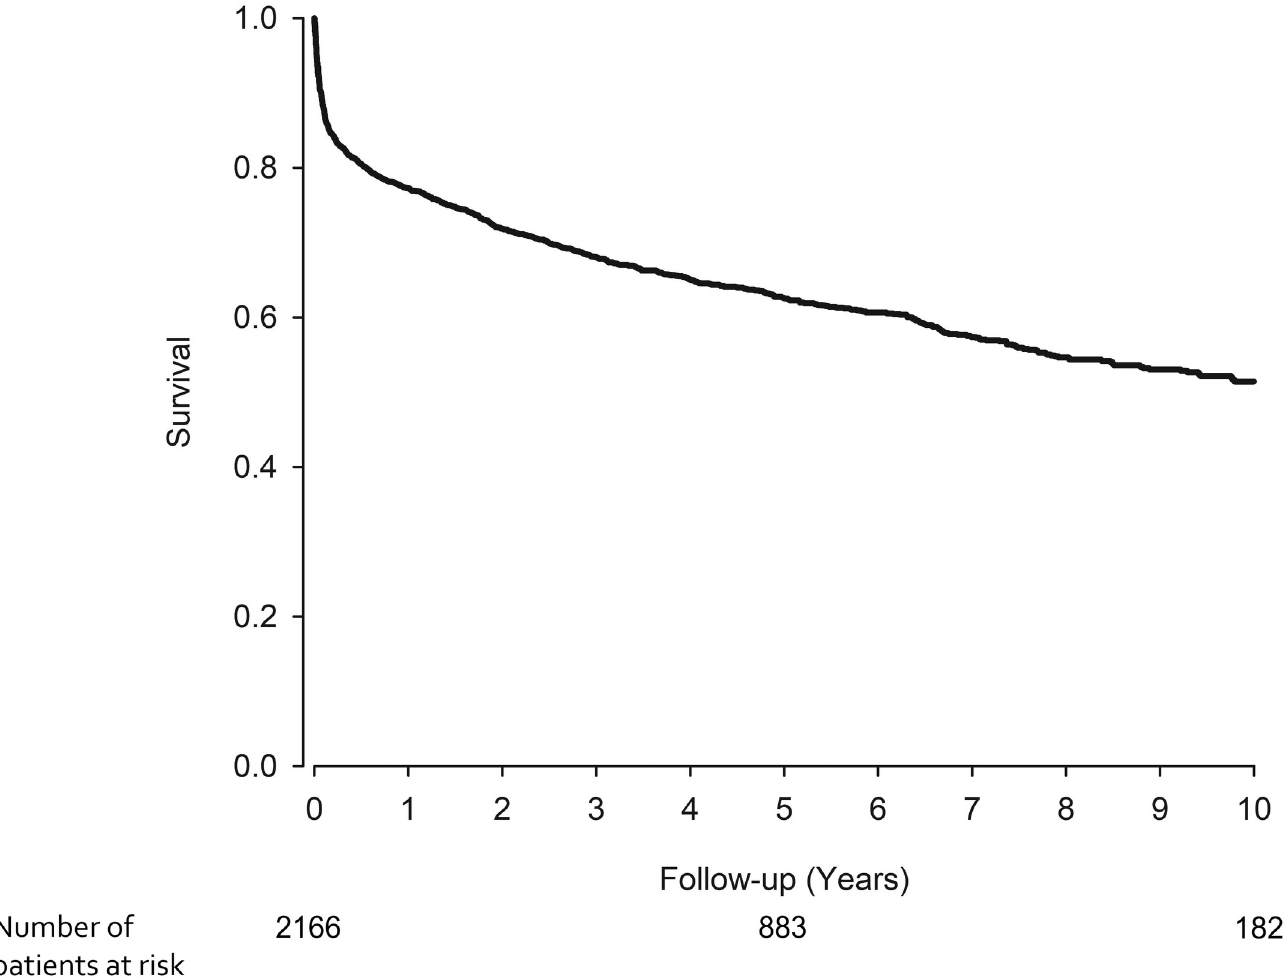
Fig 1. Overall 10-year survival of patients with infective endocarditis admission during 2005–2014 in